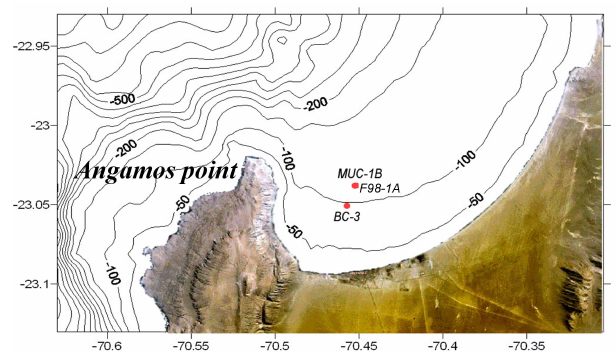
Fig. 1. Study area, Mejillones Bay, and sampling locations of cores MUC-1B, BC-3, and